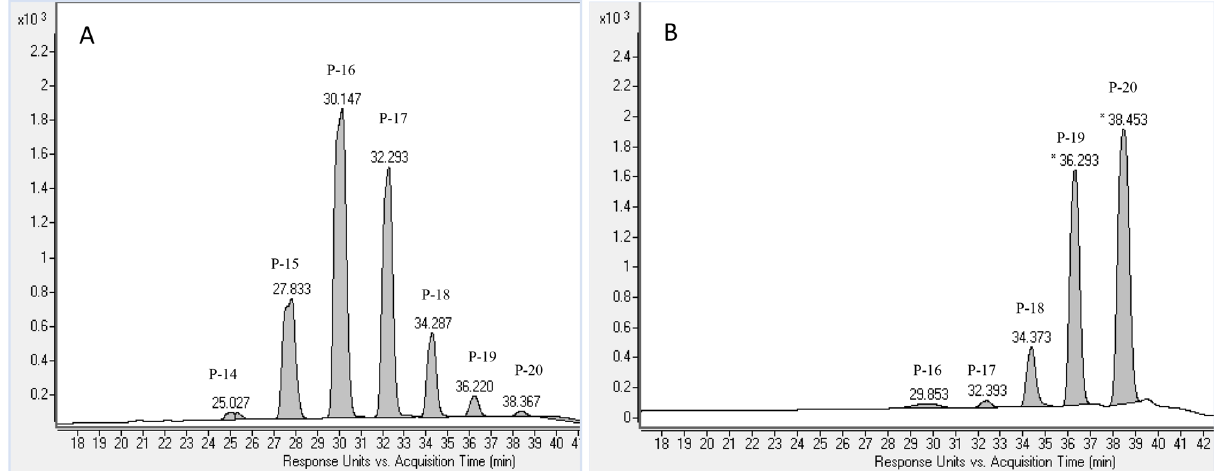
Figure 1. HPLC chromatogram of polyprenol standard mixture of ( A ) C 70 –C 100 prenologues (P14–P20) and ( B ) C